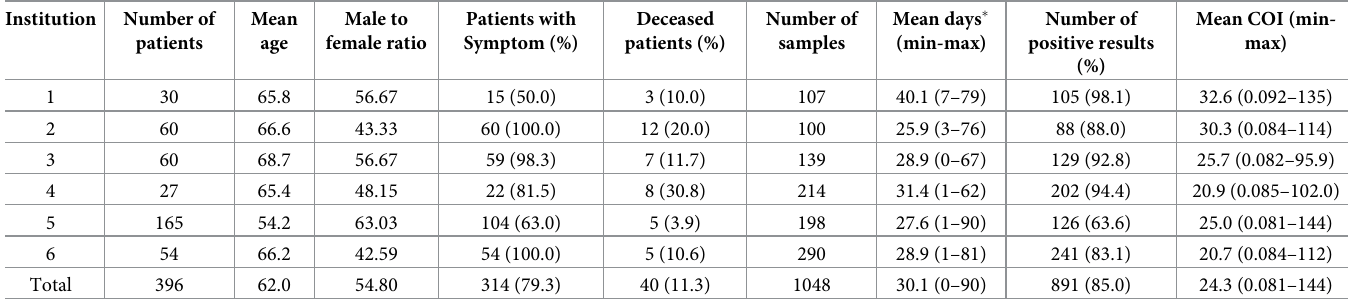
Table 1. Characteristics of the patients and samples.